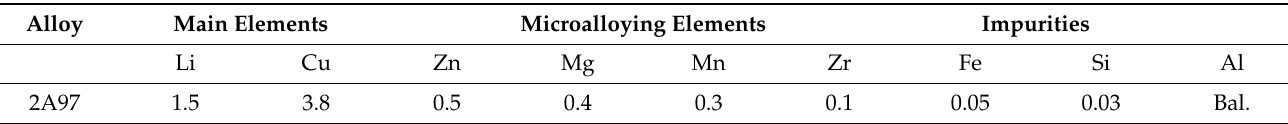
Table 1. The composition of 2A97 alloy